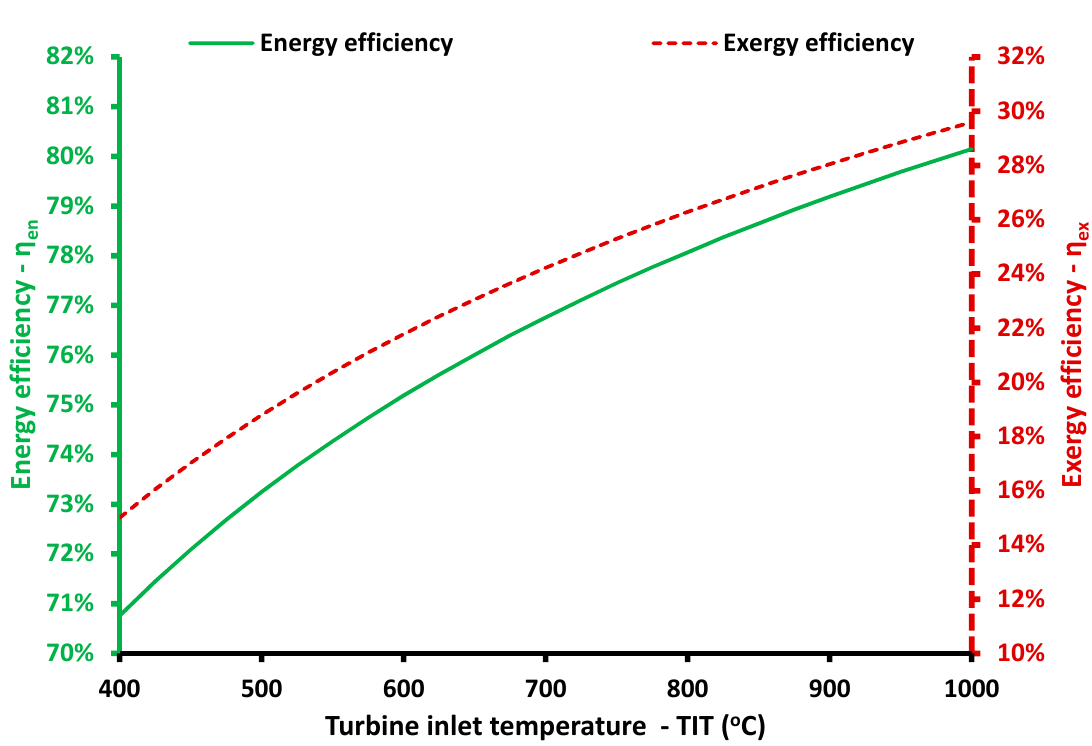
Figure 5. Energy and exergy efficiencies for different values of the turbine inlet temperature.